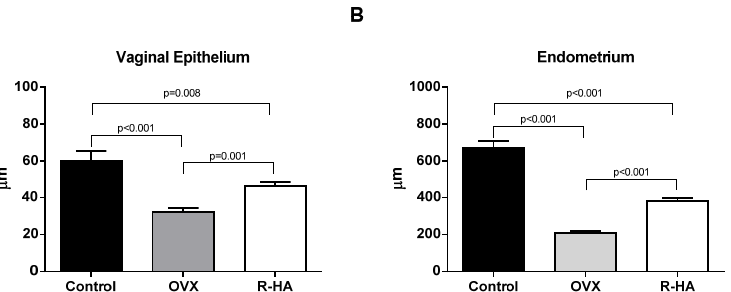
Figure 2. Effect of ovariectomy and R-HA gel administration on the thickness of vaginal epithelium ( A ) and endometrium ( B ). Data are presented as the M ± SEM. One-way ANOVA with post hoc